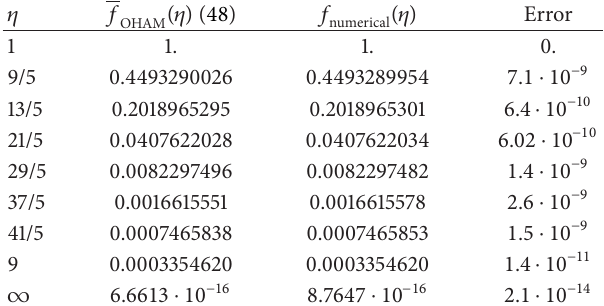
󸀠󸀠 Table 2: Comparison between the first expression of the first-order (1) Table 1: Comparison between the skin friction coefficient 𝑓 OHAM approximate solutions 𝑓(𝜂) given by (48) obtained by OHAM and (1) (error = |𝑓 󸀠󸀠 (1) − 𝑓 󸀠󸀠 (1)| ). and 𝑓 󸀠󸀠 numerical numerical OHAM (𝜂)| ). numerical